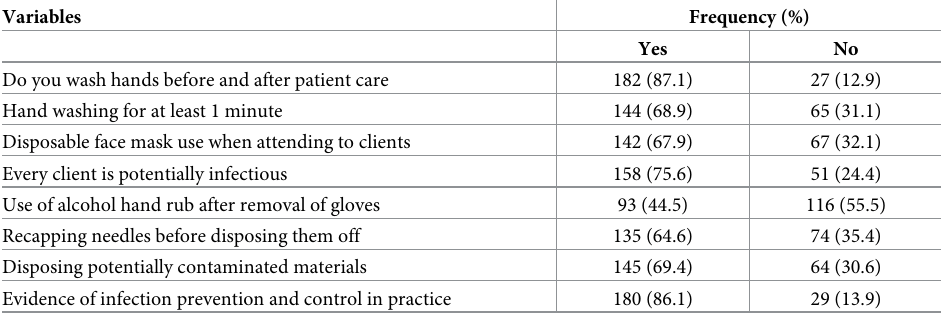
Table 4. IPC compliance among respondents (n = 209).